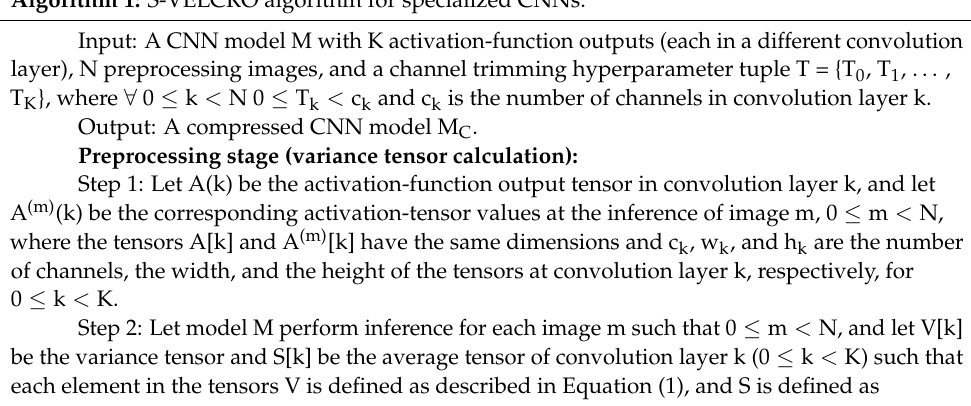
Algorithm 1: S-VELCRO algorithm for specialized